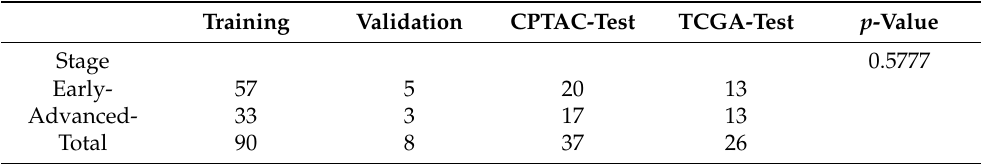
Table 2. Patients information for training, validation, and test cohorts.